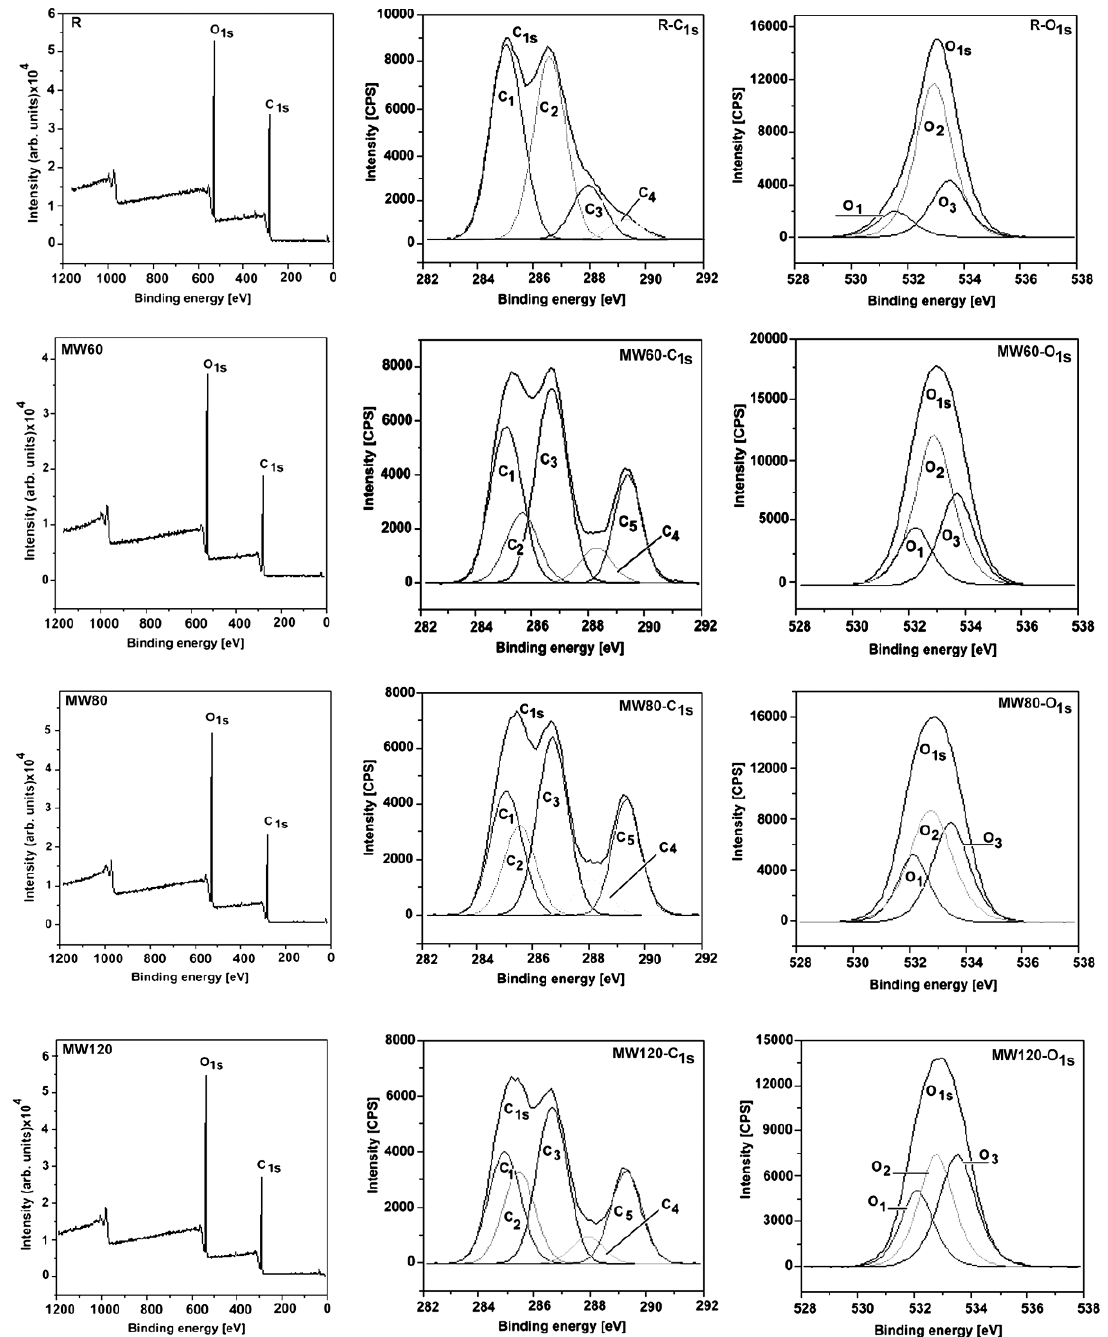
Figure 3. XPS spectra for non-modified and SA modified wood and C1s and O1s XPS survey spectra (R -C1s, R -O1s; MW60 -C1s, MW60 -O1s; MW80